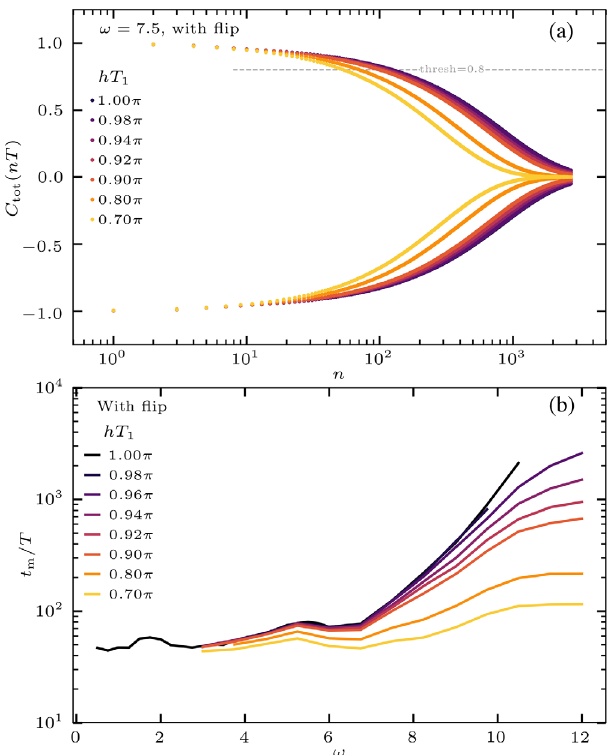
FIG. 4. Robustness of prethermal regime to drive imperfec- tions. (a) Survival of the total magnetization C length L ¼ 20 under the NMR Floquet drive (3) for driving frequency 2 π =T 1 ¼ 7 . 5 and magnetic fields h detuned from the optimal field h ¼ π =T 1 . The detuning of the spin rotation P x π ϵ ¼ 0 . 1 . (b) Number of driving periods needed to reach a thresholds of 0.8 for the same data as in panel (a).